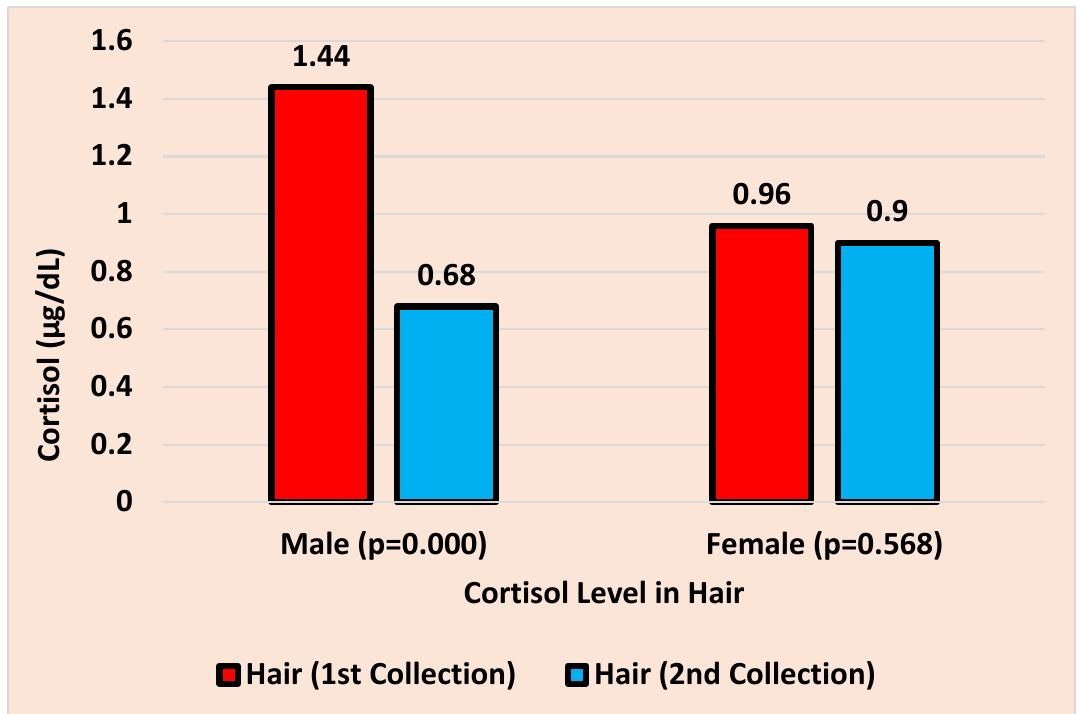
Figure 4. Gender wise comparison of cortisol levels in hair for the participating students (N-151).